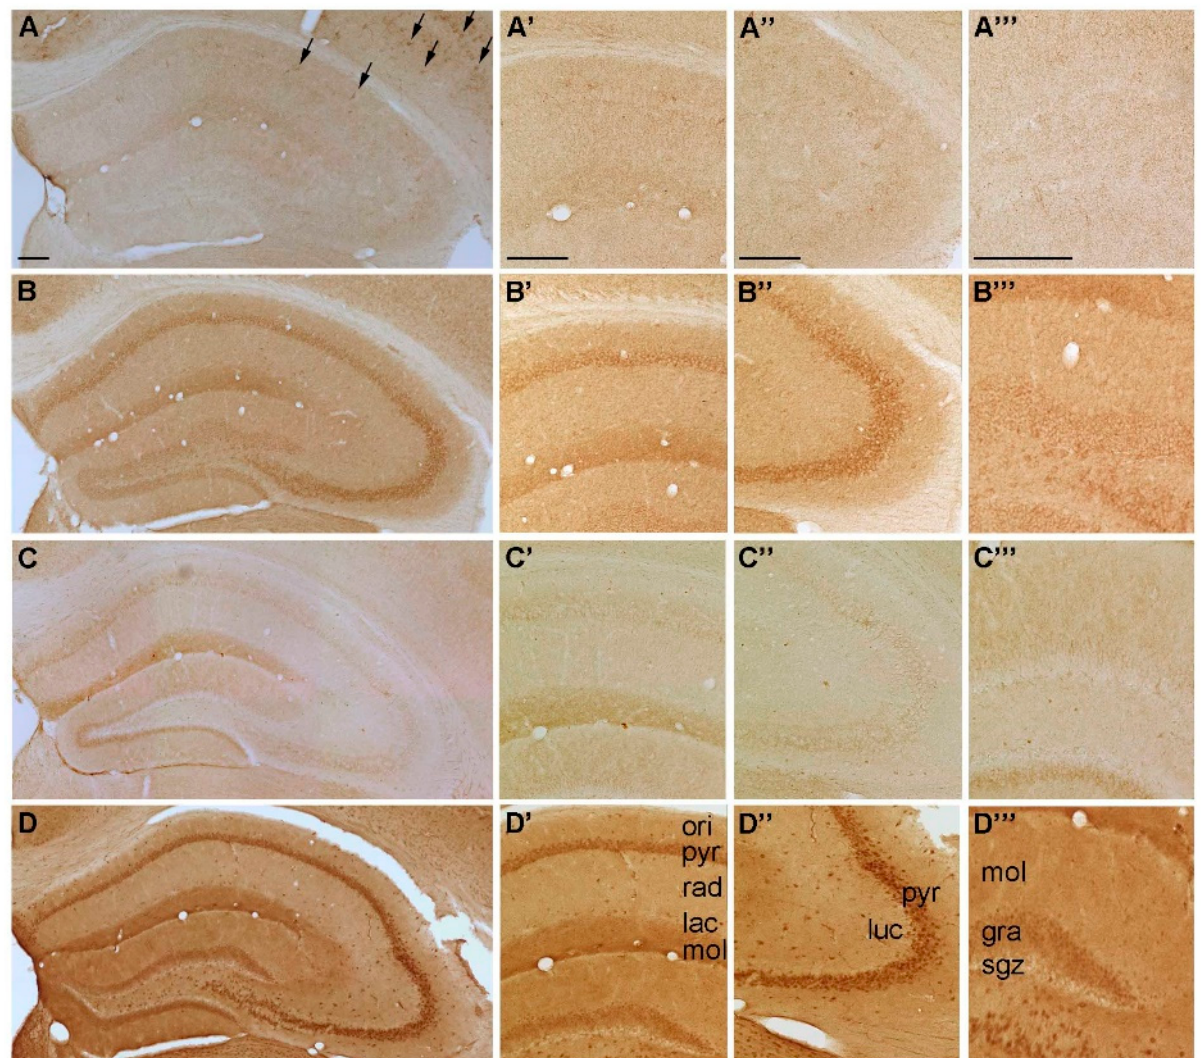
Figure 3. Representative microphotographs of ( A ) P2Y 1 -, ( B ) P2Y 2 -, ( C ) P2Y 4 and ( D ) P2Y 6 -IR in the mouse hippocampus. At higher magnification ( A’ ) P2Y1-IR in cornu ammonis (CA) 1, ( A” ) P2Y1-IR in cornu ammonis (CA) 3, ( A”’ ) P2Y1-IR in dentate gyrus, ( B’ ) P2Y2-IR in cornu ammonis (CA) 1, ( B” ) P2Y2-IR in cornu ammonis (CA) 3, ( B”’ ) P2Y2-IR in dentate gyrus, ( C’ ) P2Y4-IR in cornu ammonis (CA) 1, ( C” ) P2Y4-IR in cornu ammonis (CA) 3, ( C”’ ) P2Y4-IR in dentate gyrus, ( D’ ) P2Y6-IR in cornu ammonis (CA) 1, ( D” ) P2Y6-IR in cornu ammonis (CA) 3 and ( D”’ ) P2Y6-IR in dentate gyrus, respectively. Abbreviations: ori, stratum oriens, pyr, stratum pyramidale, rad, stratum radiatum; lac, stratum lacunosum; mol, stratum moleculare; luc, stratum lucidum; gra, stratum granulare, sgz, subgranular zone. Arrows indicate cells with interneuron-like morphology. Scale bars = 200 µm.